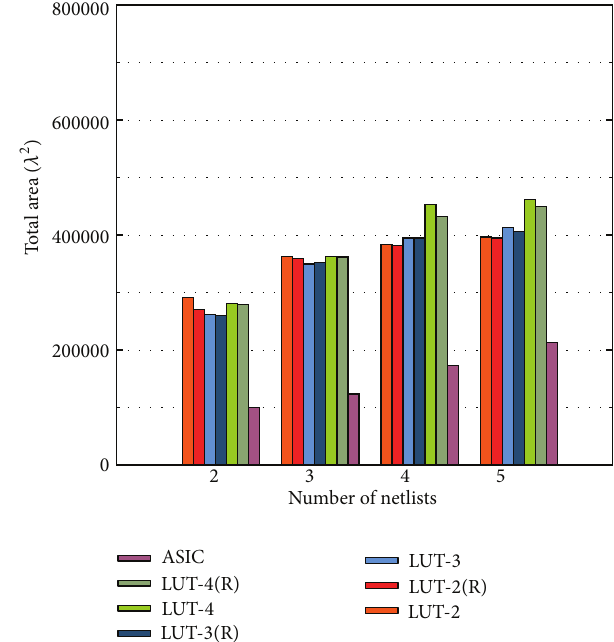
Figure 23: Total area comparison between before and after reorder- ing.